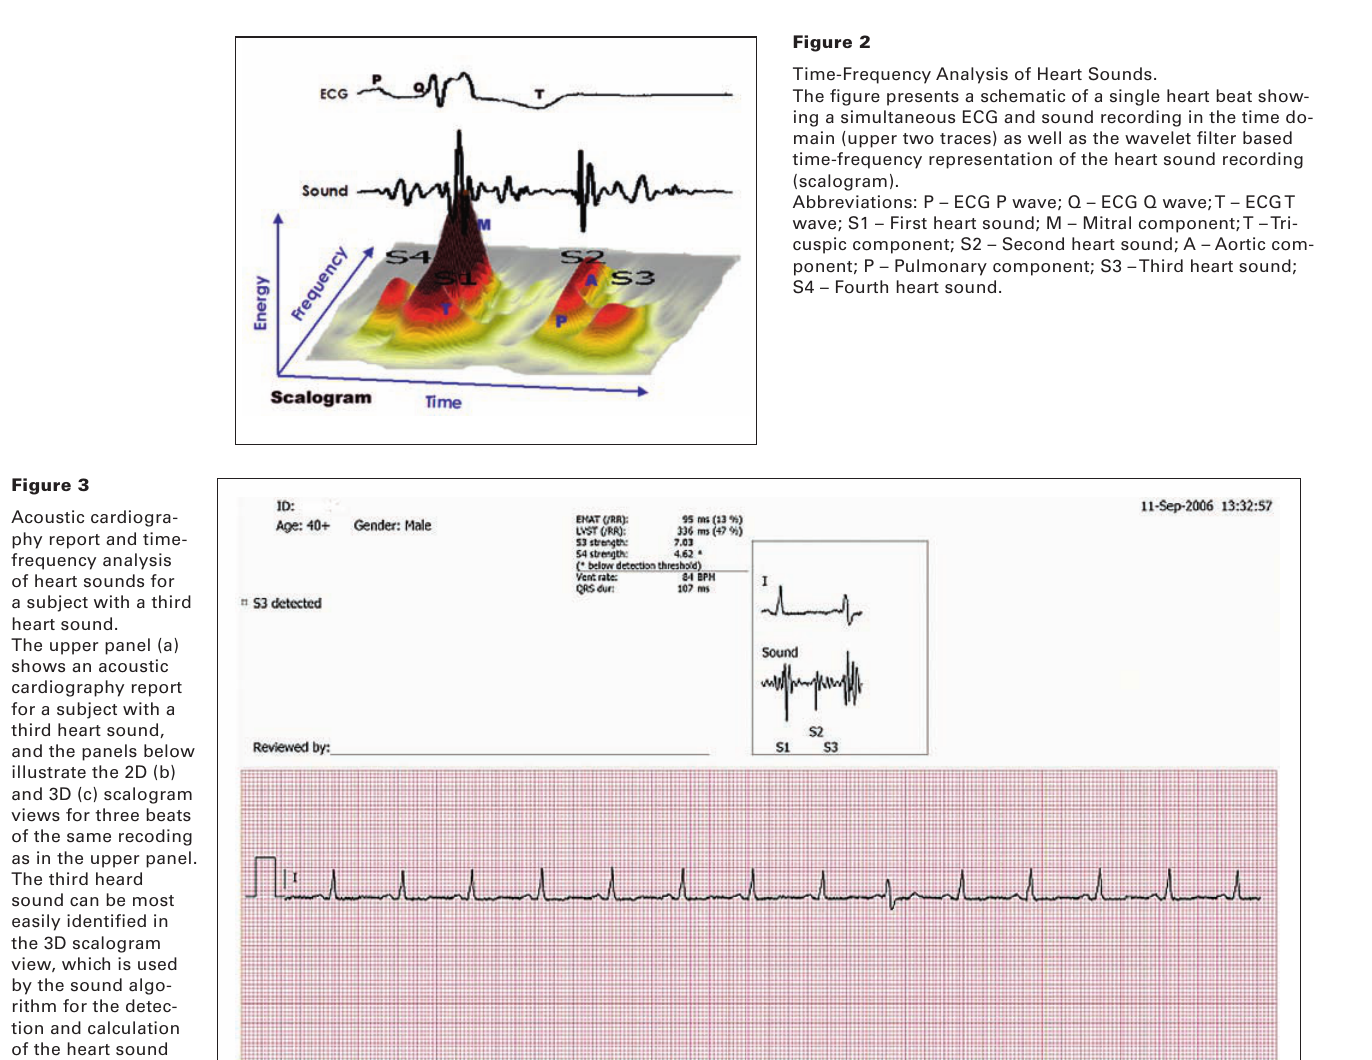
Figure 3 Acoustic cardiogra- phy report and time- frequency analysis of heart sounds for a subject with a third heart